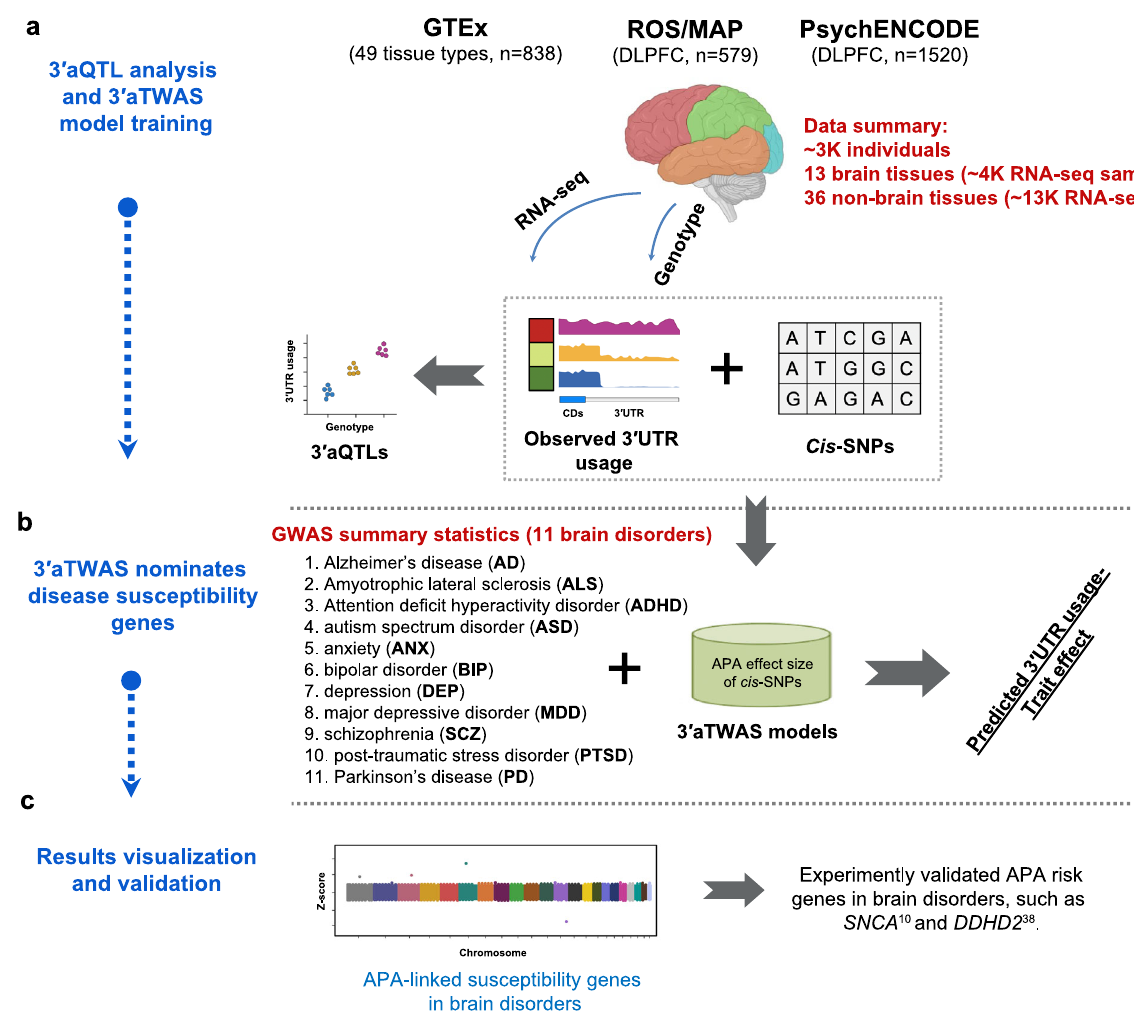
Fig. 1 | Overview of this study. a RNA-seq and matched genotype data were col- lected from the GTEx, ROS/MAP, and PsychENCODE cohorts as reference panels. We then performed 3 ′ aQTL analysis and built 3 ′ aTWAS models to predict the APA usage of target genes with cis -SNPs in the reference panels. b We performed 3